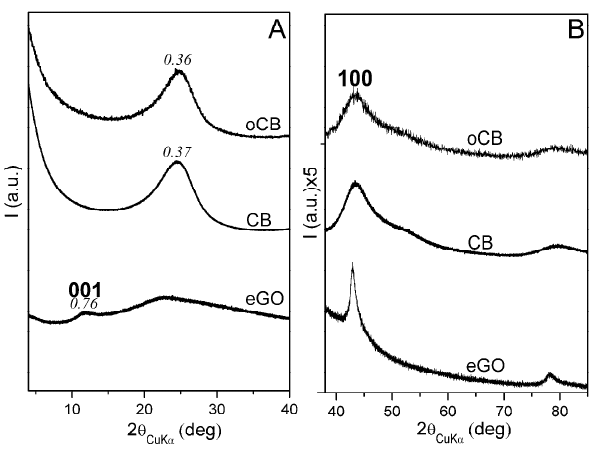
Figure 3. X-ray diffraction patterns (CuK α ) of: graphene oxide (eGO, with O/C, wt/wt = 0.62); CB sample with the highest BET specific surface area; this CB after oxidation (oCB-3, O/C, wt/wt = 0.91). Patterns in the 2 θ range 4–40° ( A ) and enlarged patterns in the 2 θ range 40–85° ( B ).